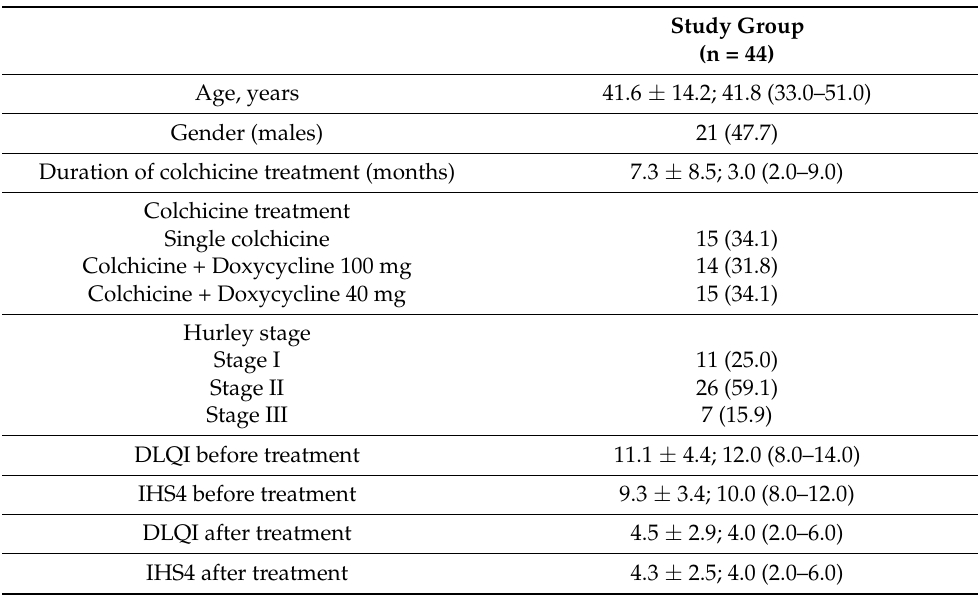
Table 1. Characteristics of the study group.